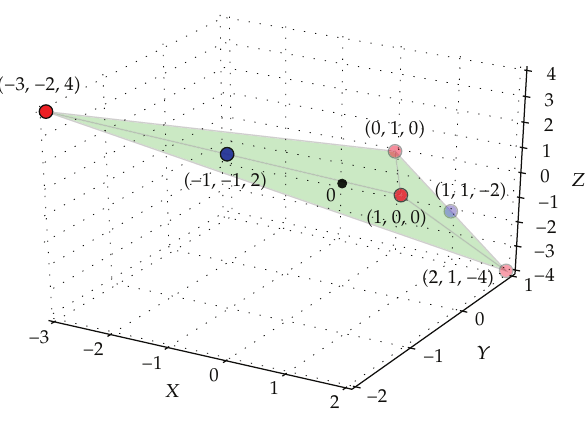
Figure 1: The rays Σ